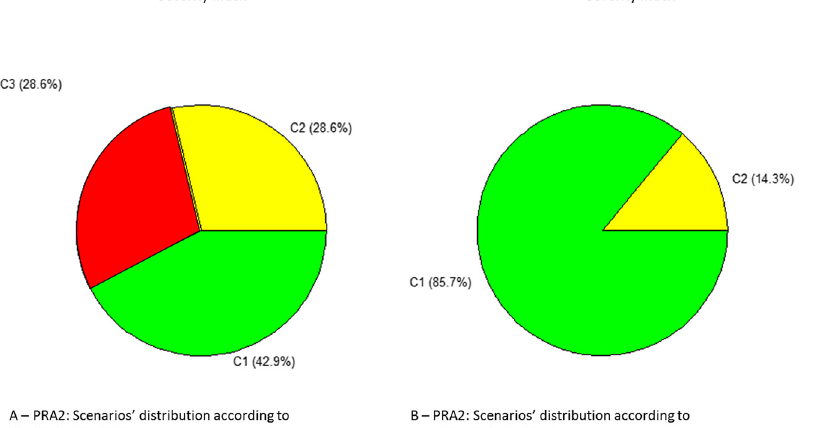
Figure 7: Farmer ’ s diagram of initial and residual risks by danger for PRA2.